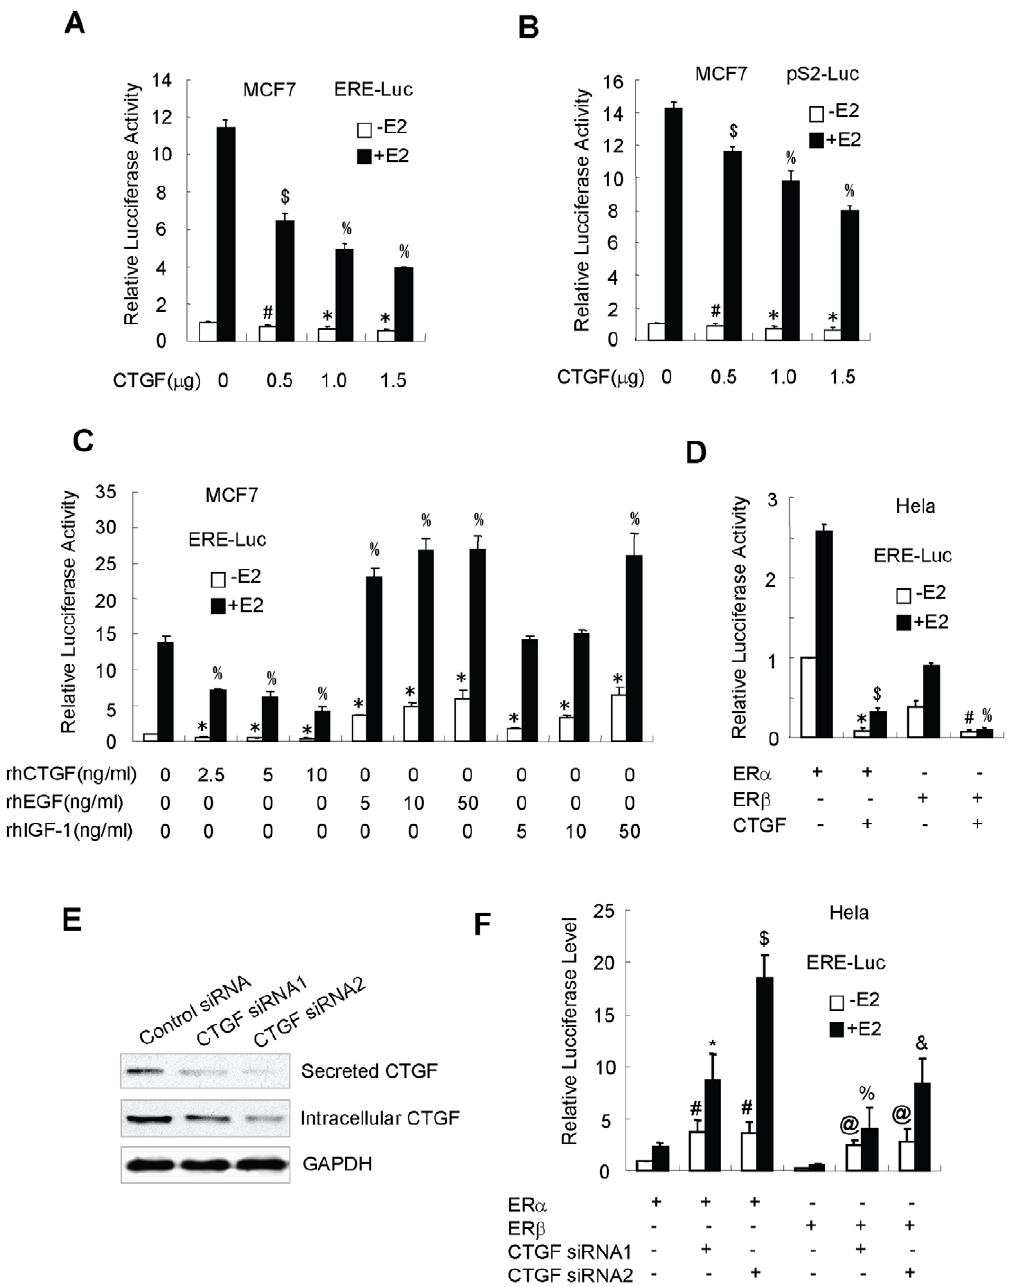
Figure 4. CTGF regulates estrogen-responsive reporter activity. ( A–C ) MCF7 cells were cotransfected with ERE-Luc (A and C) or pS2-Luc (B) reporter, and increasing amounts of plasmid expressing FLAG-tagged CTGF (A and B) or the indicated amounts of recombinant human (rh) CTGF, EGF or IGF-1 proteins (C). Cells were treated with or without 10 nm E2 for 24 h and analyzed for luciferase activity. Data shown are means 6 SD of triplicates of one representative experiment and have been repeated three times with similar results. # P , 0.05 versus empty vector without E2. * P , 0.01 versus empty vector without E2. $ P , 0.05 versus empty vector with E2. % P , 0.01 versus empty vector with E2. (D) Hela cells were co- transfected with ERE-Luc, FLAG-tagged CTGF, and ER a or ER b as indicated. Cells were treated and analyzed as in (A–C). * P , 0.01 versus ER a expression vector without E2. $ P , 0.01 versus ER a expression vector with E2. # P , 0.01 versus ER b expression vector without E2. % P , 0.01 versus ER b expression vector with E2. (E) Hela cells were transfected with expression vector for CTGF siRNA1, CTGF siRNA2 or scramble siRNA (control) plasmid. Cells were harvested and lysed, and conditioned medium was concentrated using a 10-kDa membrane. Both the concentrate and the cell lysate were used for immunoblotting of the expression of CTGF, and the whole cell lysate was used for immunoblotting of the expression of GAPDH. (F) Hela cells were cotransfected with ERE-Luc, ER a or ER b , and CTGF siRNA1 or CTGF siRNA2, as indicated. Cells were treated and analyzed as in (A–C). # P , 0.05 versus ER a expression vector without E2. * P , 0.05 versus ER a expression vector with E2. $ P , 0.01 versus ER a expression vector with E2. @ P , 0.05 versus ER b expression vector without E2. % P , 0.05 versus ER b expression vector with E2. & P , 0.01 versus ER b expression vector with E2.